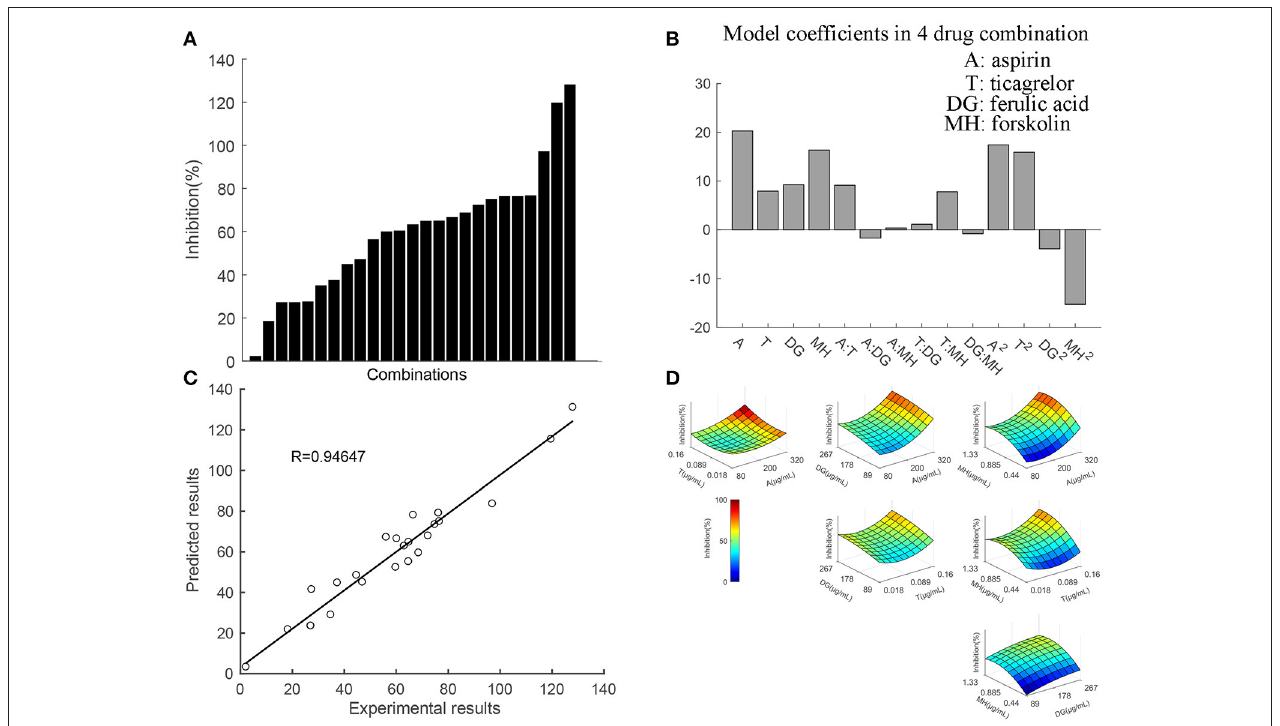
FIGURE 5 | Results and data analysis of the 4-drug combination system. (A) The anti-platelet efficacies of the 25 drug combinations of 4-drug system investigated in generation 2. (B) Regression coefficients from the quadratic model were provided based on the obtained data. The positive values of A:T (aspirin:ticagrelor) and T:MH (ticagrelor:forskolin) indicated synergy between the two drug pairs, while negative values of A:DG (aspirin:ferulic acid) and DG:MH (ferulic acid:forskolin) suggested antagonism between them. (C) The correlation between experimentally tested efficacies (x-axis) and model predicted inhibition rate of the 25 drug combinations was shown. The correlation coefficient of the model is 0.94, which means the model can predict the experimental points with high fidelity. (D) The figure showed the model predicted anti-platelet efficacies when the concentrations of two drugs are held at constant while the concentrations of the other two drugs are